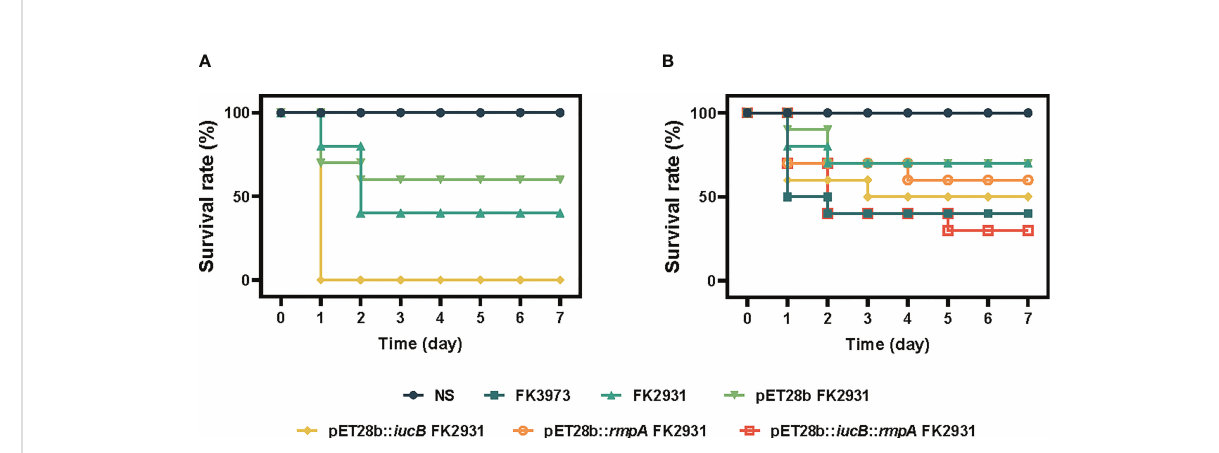
FIGURE 1 Survival rate of G. mellonella larvae. (A) iucB enhanced the virulence of K. pneumoniae . (B) Effect of rmpA on the virulence of